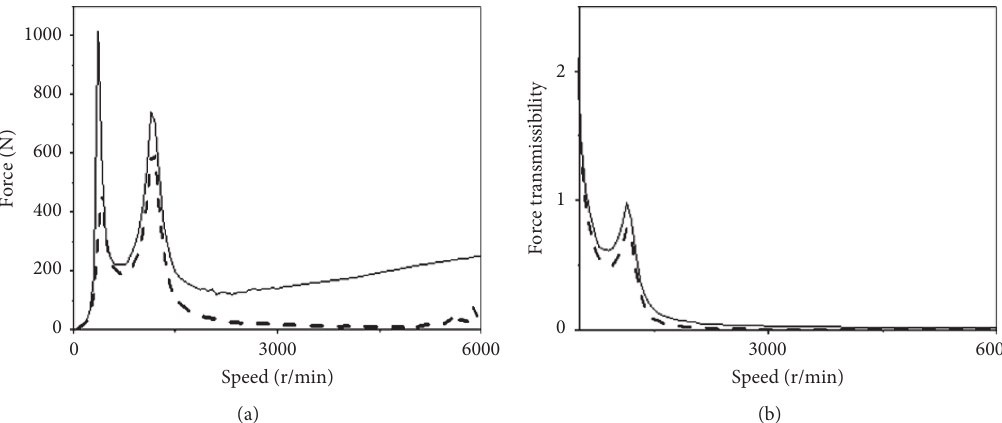
Figure 12: Force and force transmissibility of the two-stage isolation system. Solid line: passive isolation; dashed line: optimal control. (a) Force/N. (b) Force transmissibility.